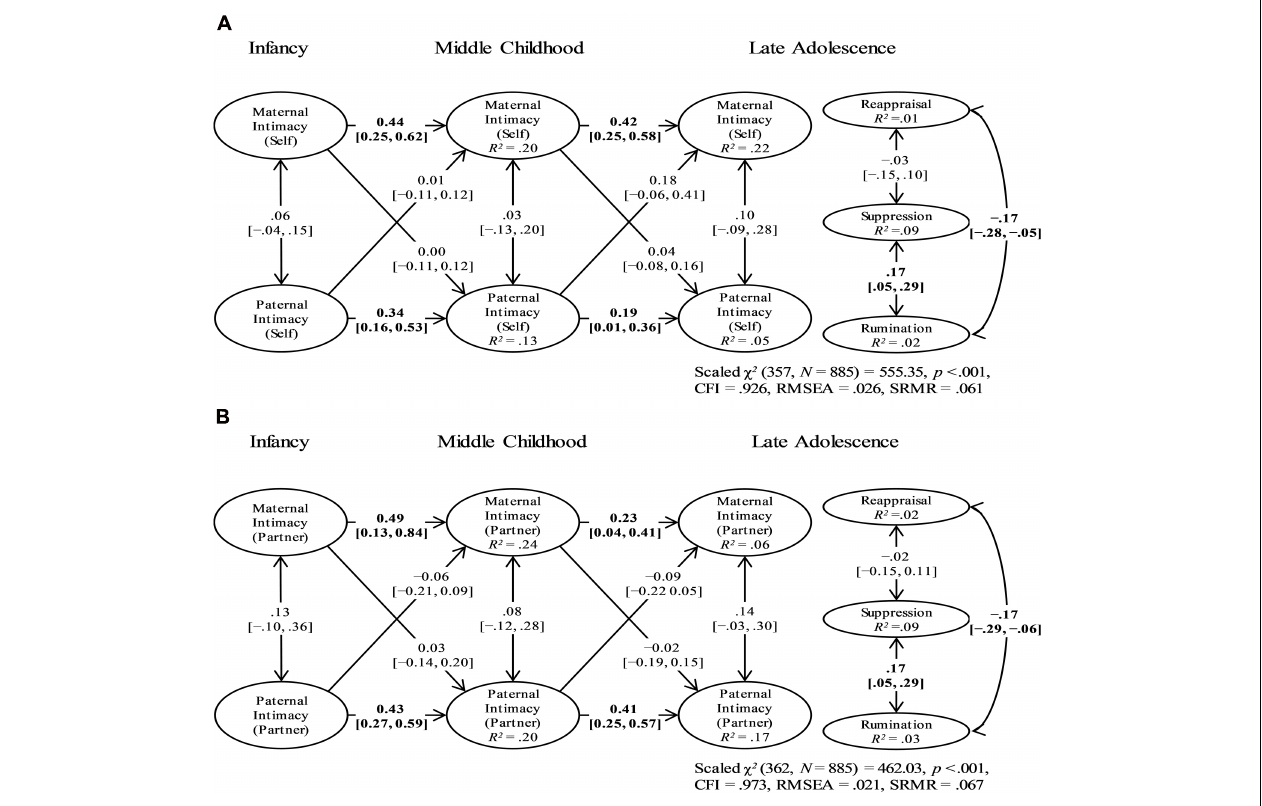
FIGURE 3 | The Final Self-Reported (A) and Partner-Reported (B) Parental Intimacy Models: Standardized Parameter Estimates and 95% Confidence Intervals. There were no effects of maternal or paternal intimacy in infancy, middle childhood, and late adolescence on adolescents’ emotion regulation patterns. Bolded values represent paths in which the 95% confidence interval did not contain zero. The factor loadings and error term correlations of parental autonomy indicators and the path coefficients of covariates are not shown. CFI = robust comparative fit index; RMSEA = robust root-mean-square error of approximation; SRMR = standardized root mean square